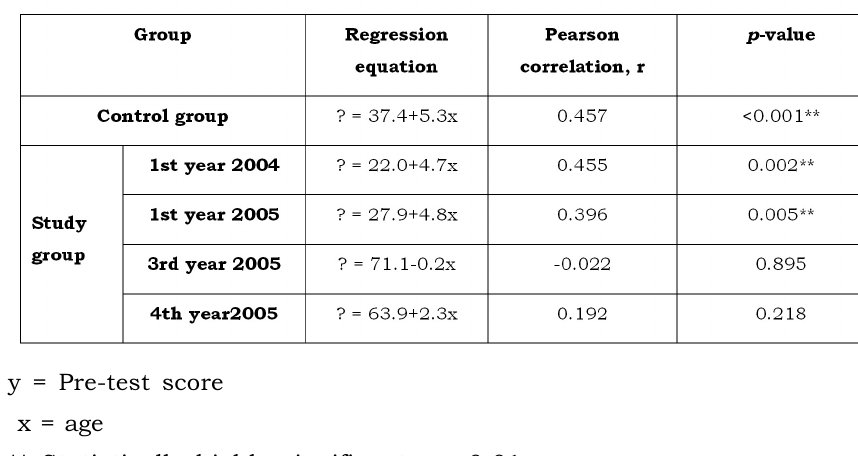
Table 5a: Regression and correlation analysis